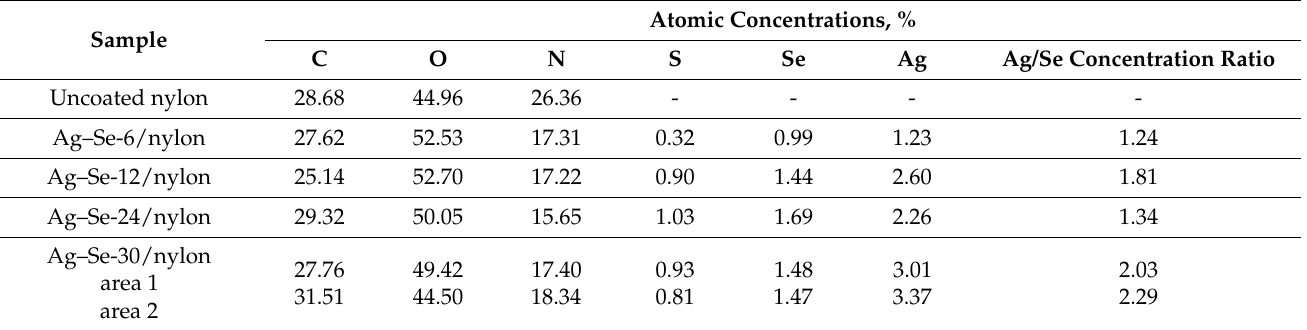
Table 1. Elemental composition of the Ag–Se/nylon nanocomposites obtained by EDS acquired from the surface area marked in Figure